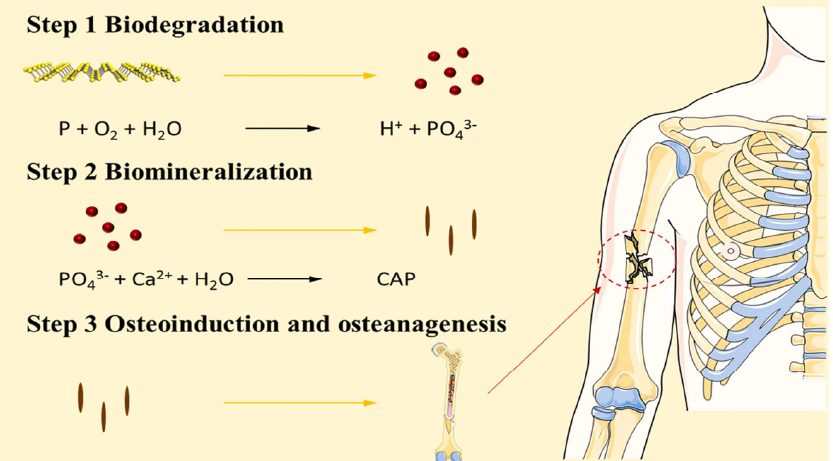
Figure 2. Black phosphorus degrades to phosphate in the presence of oxygen and water. Phosphate can capture calcium ions in the microenvironment and form biomineralization locally. Reproduced with permission from [72], Colloids and Surfaces B − Biointerfaces, 2022.